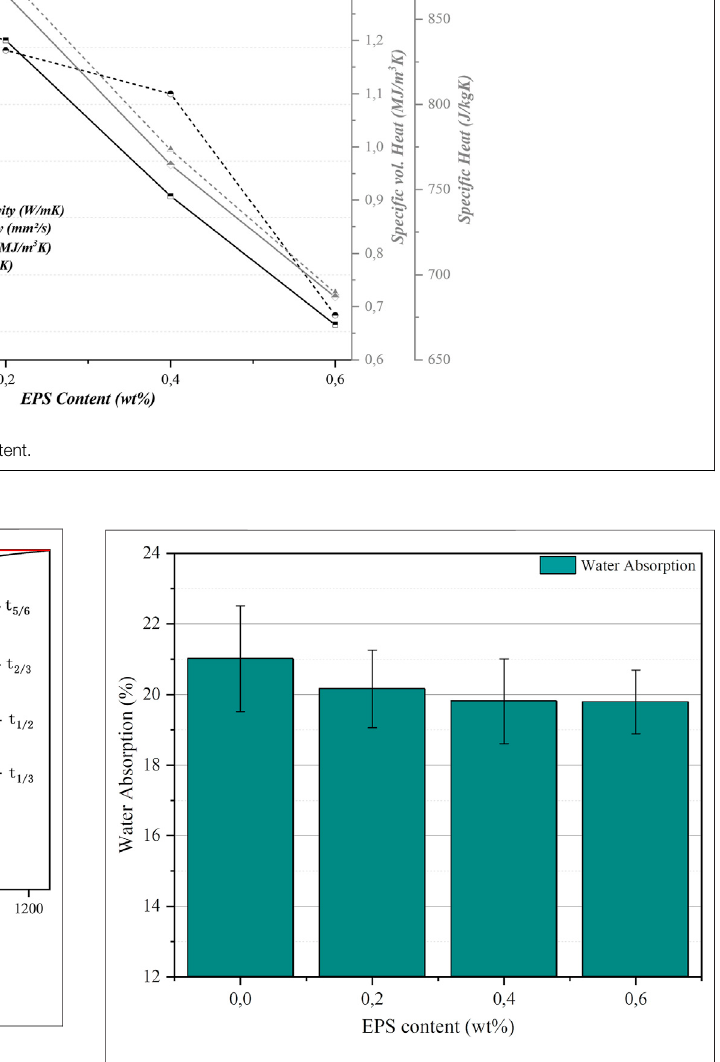
FIGURE 8 | Water absorption versus EPS content.